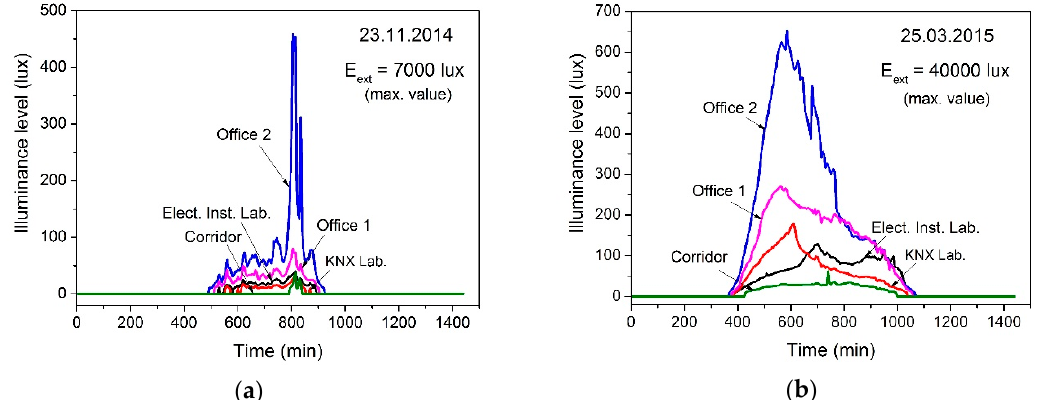
Figure 7. Daylight illuminance level in rooms ( a ) on a cloudy day (23 November 2014) and ( b ) on a sunny day (25 March 2015).